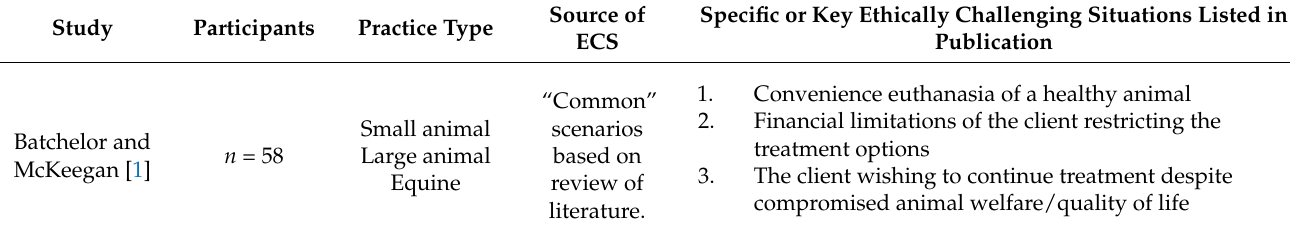
Table 2. Specific or key ethically challenging situations (ECS) encountered in veterinary settings explored in published surveys/reviews, utilised for initial coding of